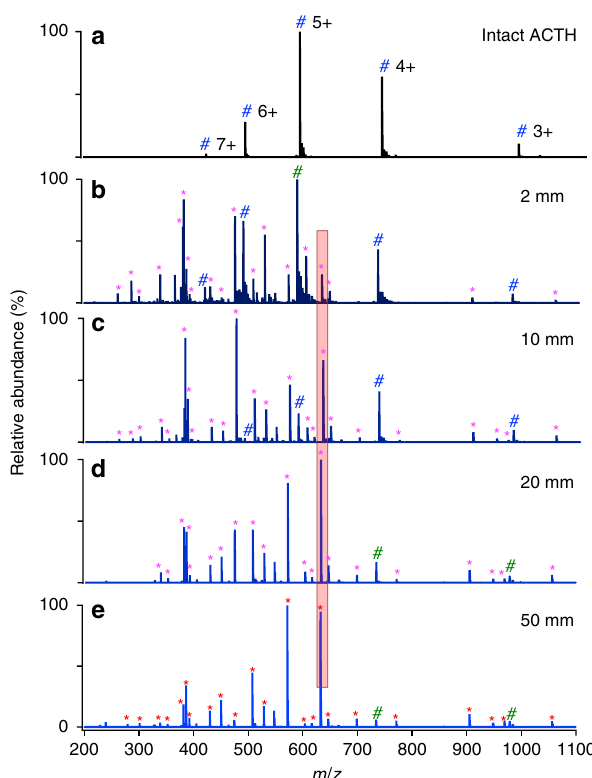
Fig. 2 Mass spectra of 10- µ M human ACTH (1 – 24) in 5-mM aqueous NH 4 HCO 3 sprayed by the homemade sprayer. a undigested (no trypsin); b – e digested with 5 µ g mL − 1 trypsin at different travel distances between the sprayer tip and MS inlet for 2, 10, 20, and 50 mm, respectively. Magenta asterisks denote the peptide fragments, and blue #s mark undigested ACTH